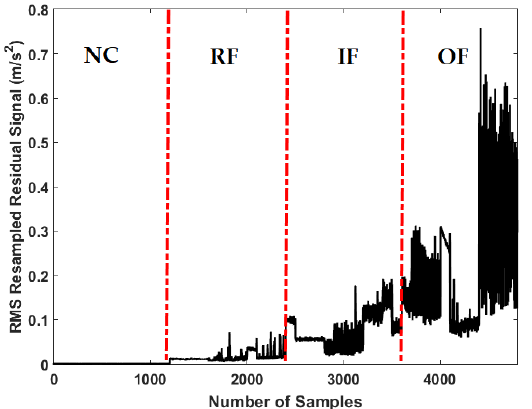
Figure 8. The RMS resampled residual signals using the MGPRLF-RPI technique for NC, RF, IF, and OF.